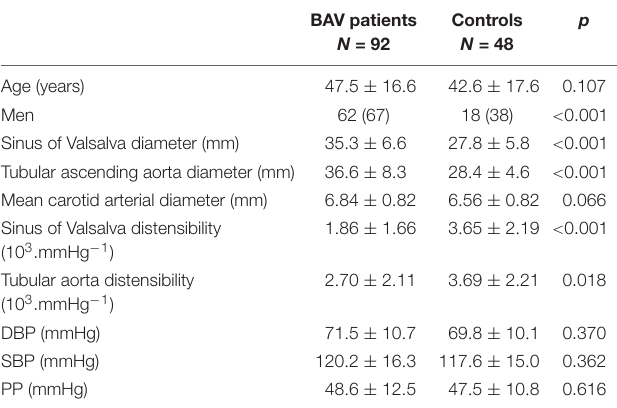
TABLE 1 | Characteristics of BAV patients and